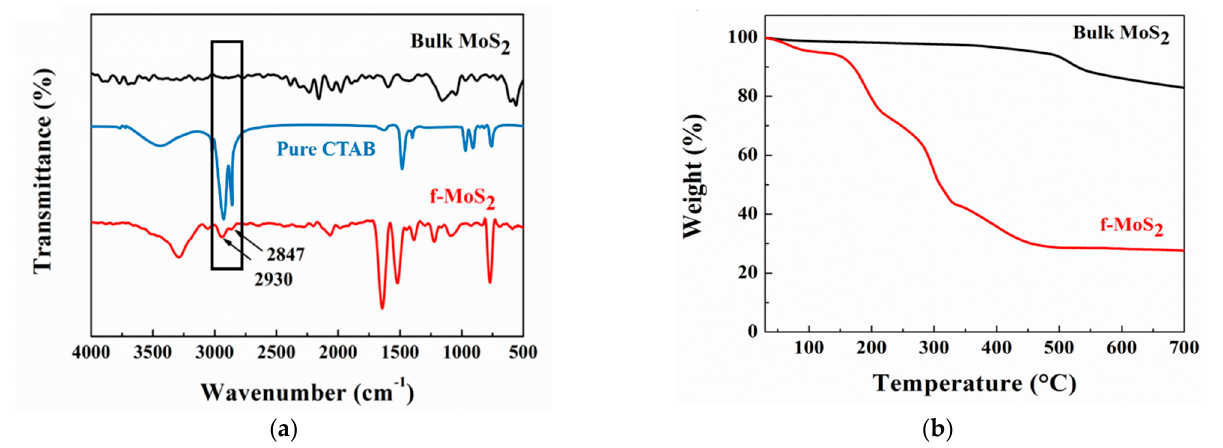
Figure 4. ( a )FTIR spectra pure CTAB, bulk MoS 2 and exfoliated f-MoS 2 nanoplatelets( b ) TGA curves of bulk MoS 2 and Figure 4. ( a ) FTIR spectra pure CTAB, bulk MoS 2 and exfoliated f-MoS 2 nanoplatelets ( b ) TGA curves of bulk MoS 2 and exfoliated f-MoS 2 nanoplatelets. exfoliated f-MoS 2